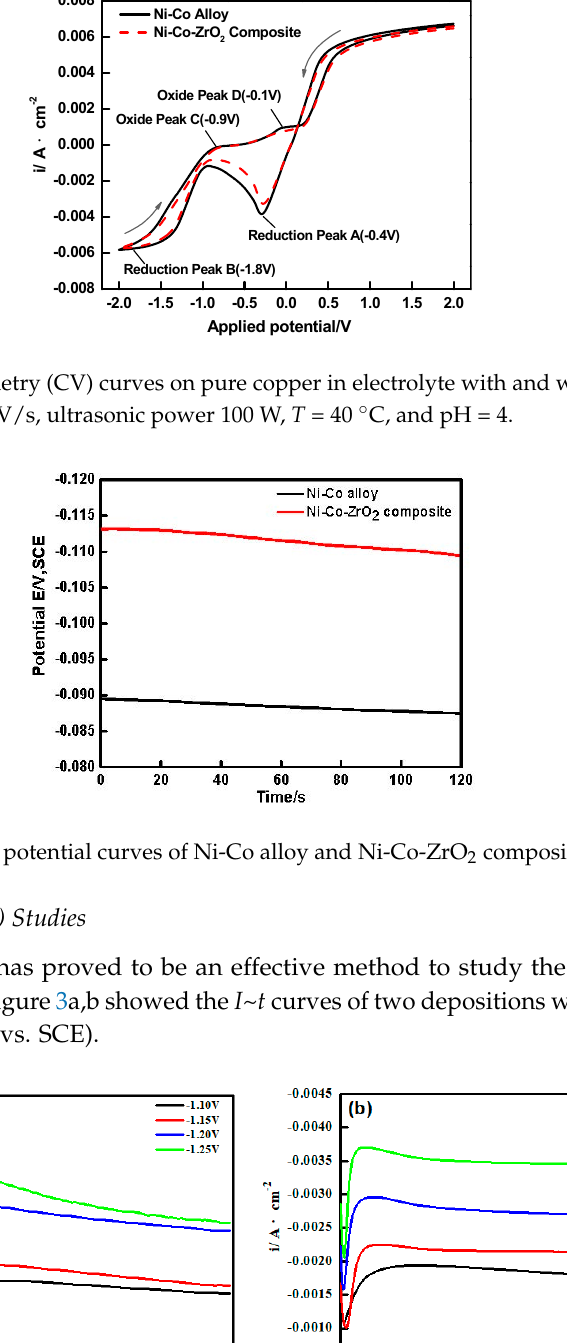
Figure 3. I ~ t curves for ( a ) Ni-Co and ( b ) Ni-Co-ZrO 2 deposition on pure copper plate at different potential, ultrasonic power 100 W, T = 40 °C, pH = 4.